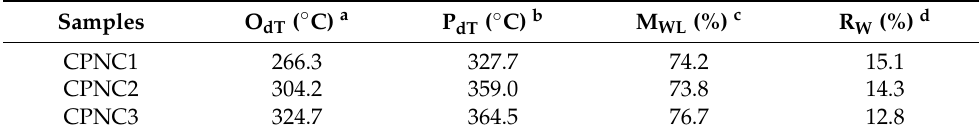
Figure 5. ( a ) TGA and ( b ) DTG spectra of CPNC1, CPNC2, and CPNC3 samples. Table 2. Thermal data of CPNC1, CPNC2, and CPNC3 samples.